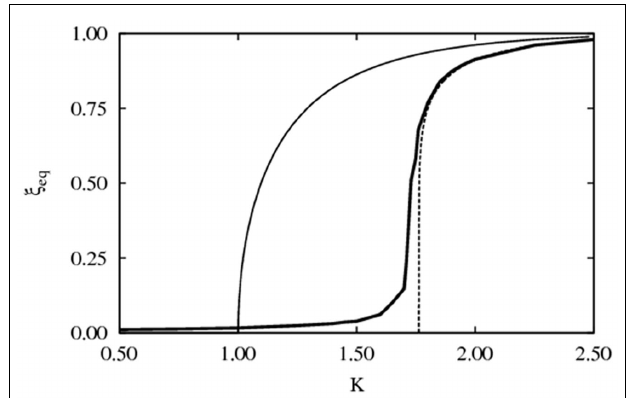
FIGURE 4 | Survival probability function Ψ ( τ ) for the global order parameter evaluated on a 2D lattice with L = 50, g 0 = 0.01 and increasing values of the coupling constant K . The straight line corresponds to a slope of − 0.50, namely μ = 1.5 since Ψ ( τ ) ∝ 1/ τ μ − 1 . (From Turalska et al., 2011, with